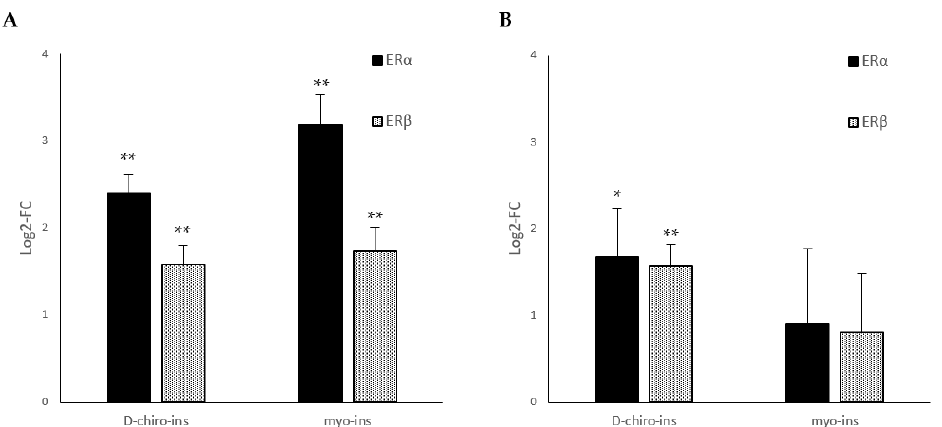
Figure 4. Modulation of estrogen receptor mRNA expression in ( A ) SGBS and ( B ) LiSa-2 differentiated adipocytes treated with D-chiro-Ins (60 µ M) or myo-Ins (60 µ M) for 72 h, with a single medium change at 36 h. Results are reported as mean ± SD of data obtained from 3 independent experiments in technical triplicate. Bars show log 2-fold change (treated vs. control). Data were analyzed by one-way ANOVA. p -values ≤ 0.05 were considered statistically significant. * p < 0.05; ** p < 0.01 versus control.